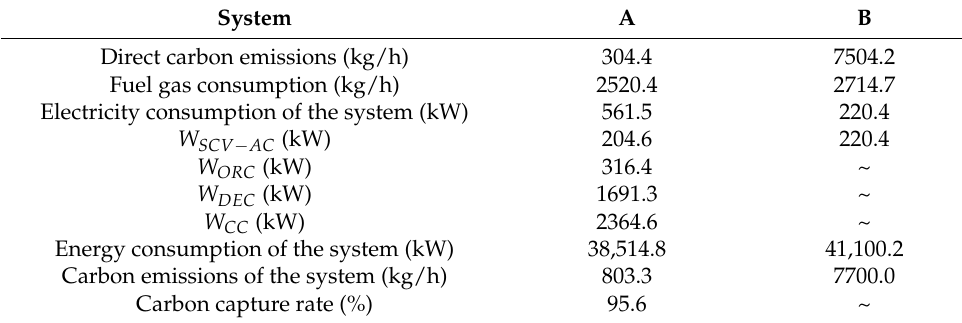
Table 6. Energy consumption and carbon emissions of the system.